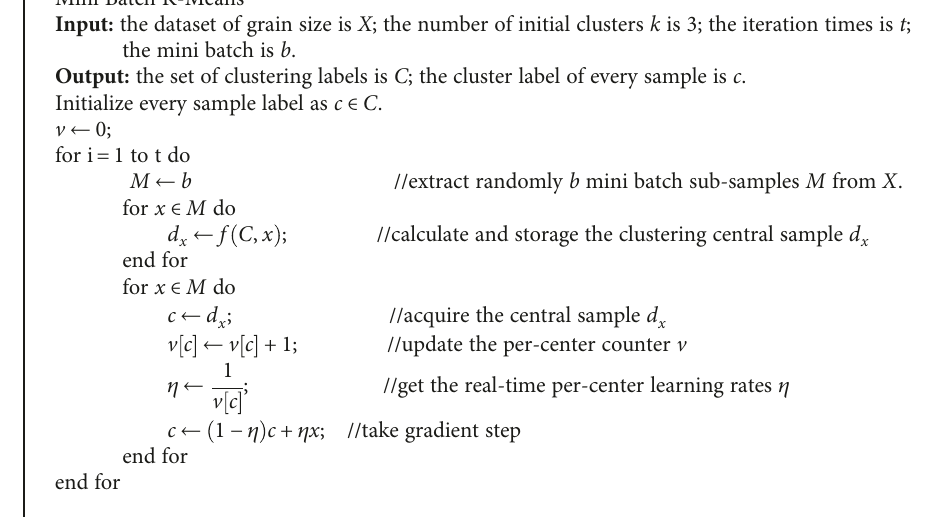
Algorithm 1: Pseudocode of Mini Batch K-means algorithm for sediment sample data processing.